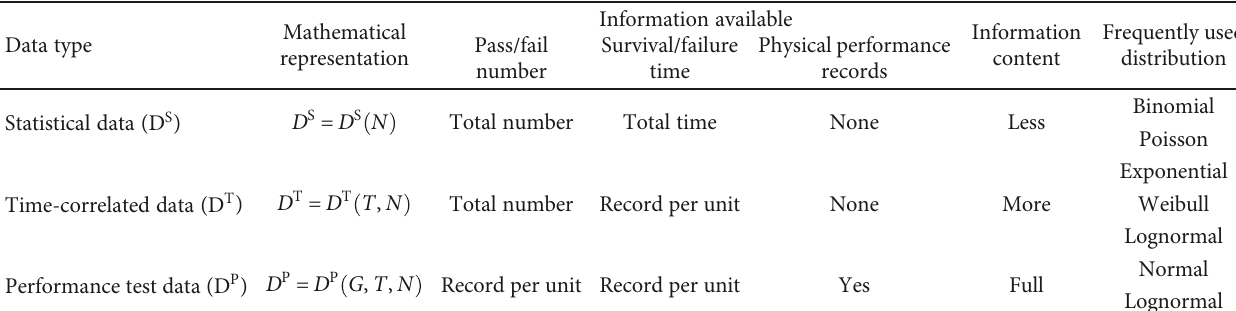
Figure 4: Graphical description of the proposed MSDII system. Table 1: Summary of the three types of data